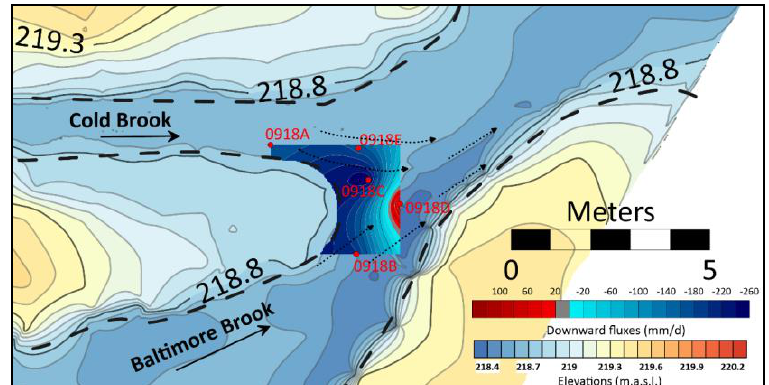
Figure 9. Vertical hyporheic fluxes (mm/day) for September 2018, derived from temperature profiles. Downwelling and upwelling fluxes are represented by red and blue contours, respectively. The light blue contour represents an interpolated transitional zone.